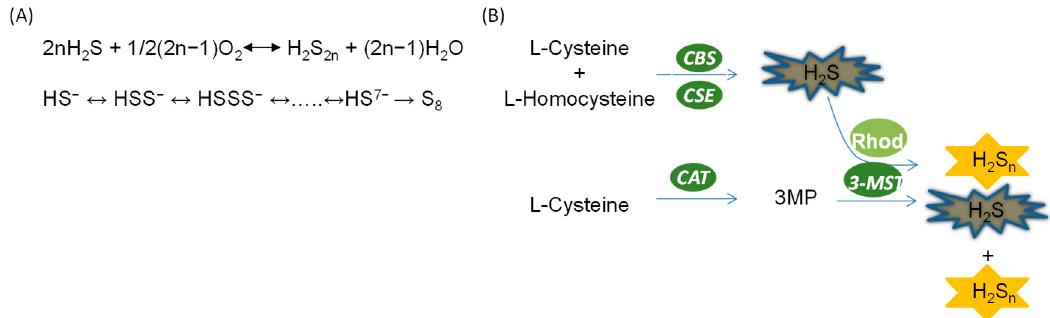
Figure 2. Generation of hydrogen polysulfides in the kidney. ( A ) Non-enzymatic production of hydrogen polysulfide; ( B ) enzymatic production of hydrogen polysulfide.